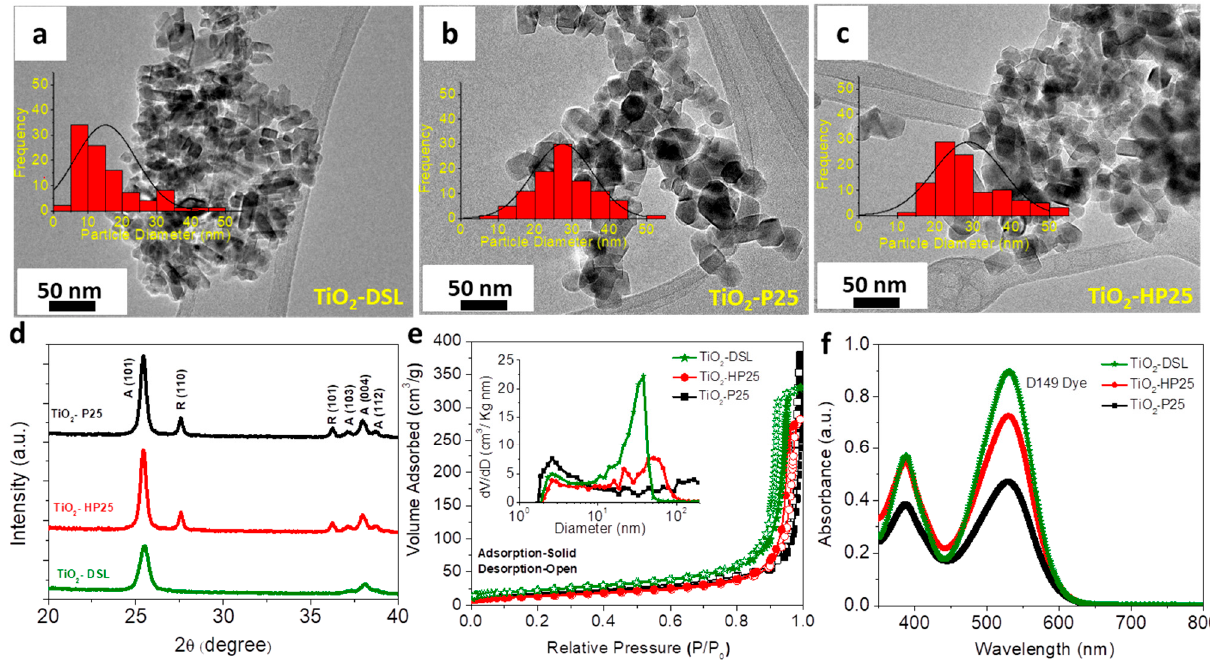
Figure 1. ( a – c ) TEM images, ( d ) XRD diffraction patterns, and ( e ) BET and BJH isotherm plots of TiO 2 -DSL, TiO 2 -HP25, and TiO 2 -P25 nanoparticles. ( f ) Absorbance spectra of desorbed D149 dye from TiO 2 -DSL, TiO 2 -HP25, and TiO 2 -P25 thin films.